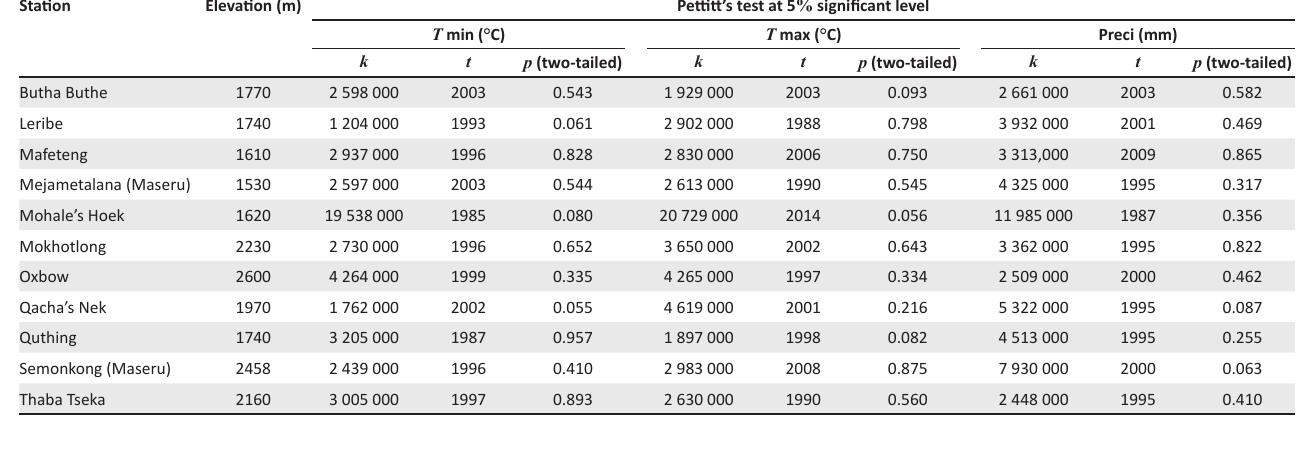
TABLE 4: Non-parametric homogeneity test (Pettitt’s test).